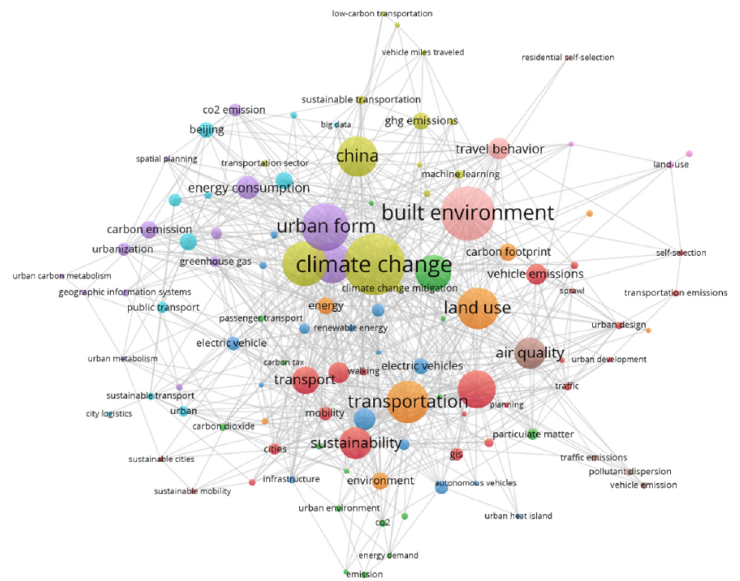
Figure 2. Keyword co-occurrence network.